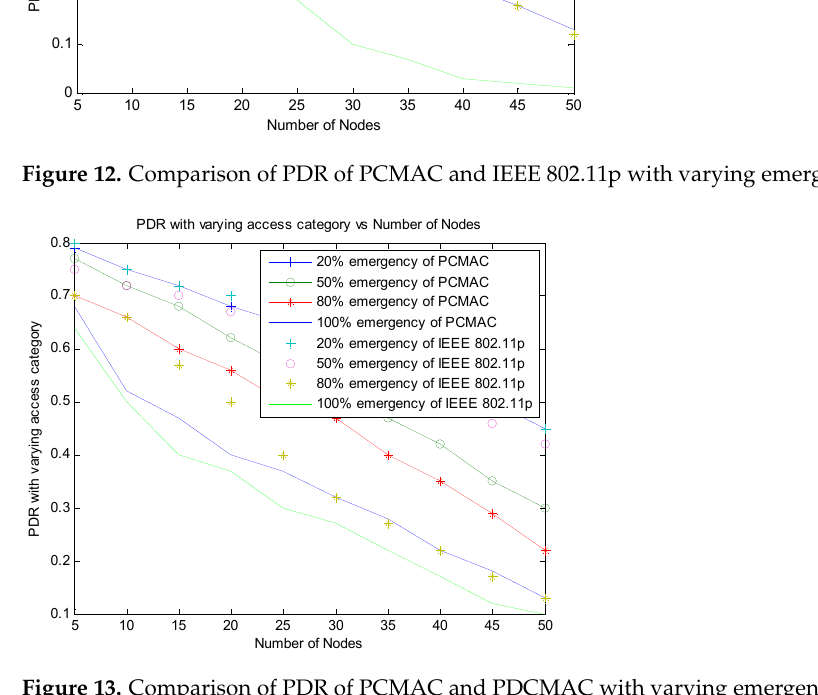
Figure 13. Comparison of PDR of PCMAC and PDCMAC with varying emergency packets.